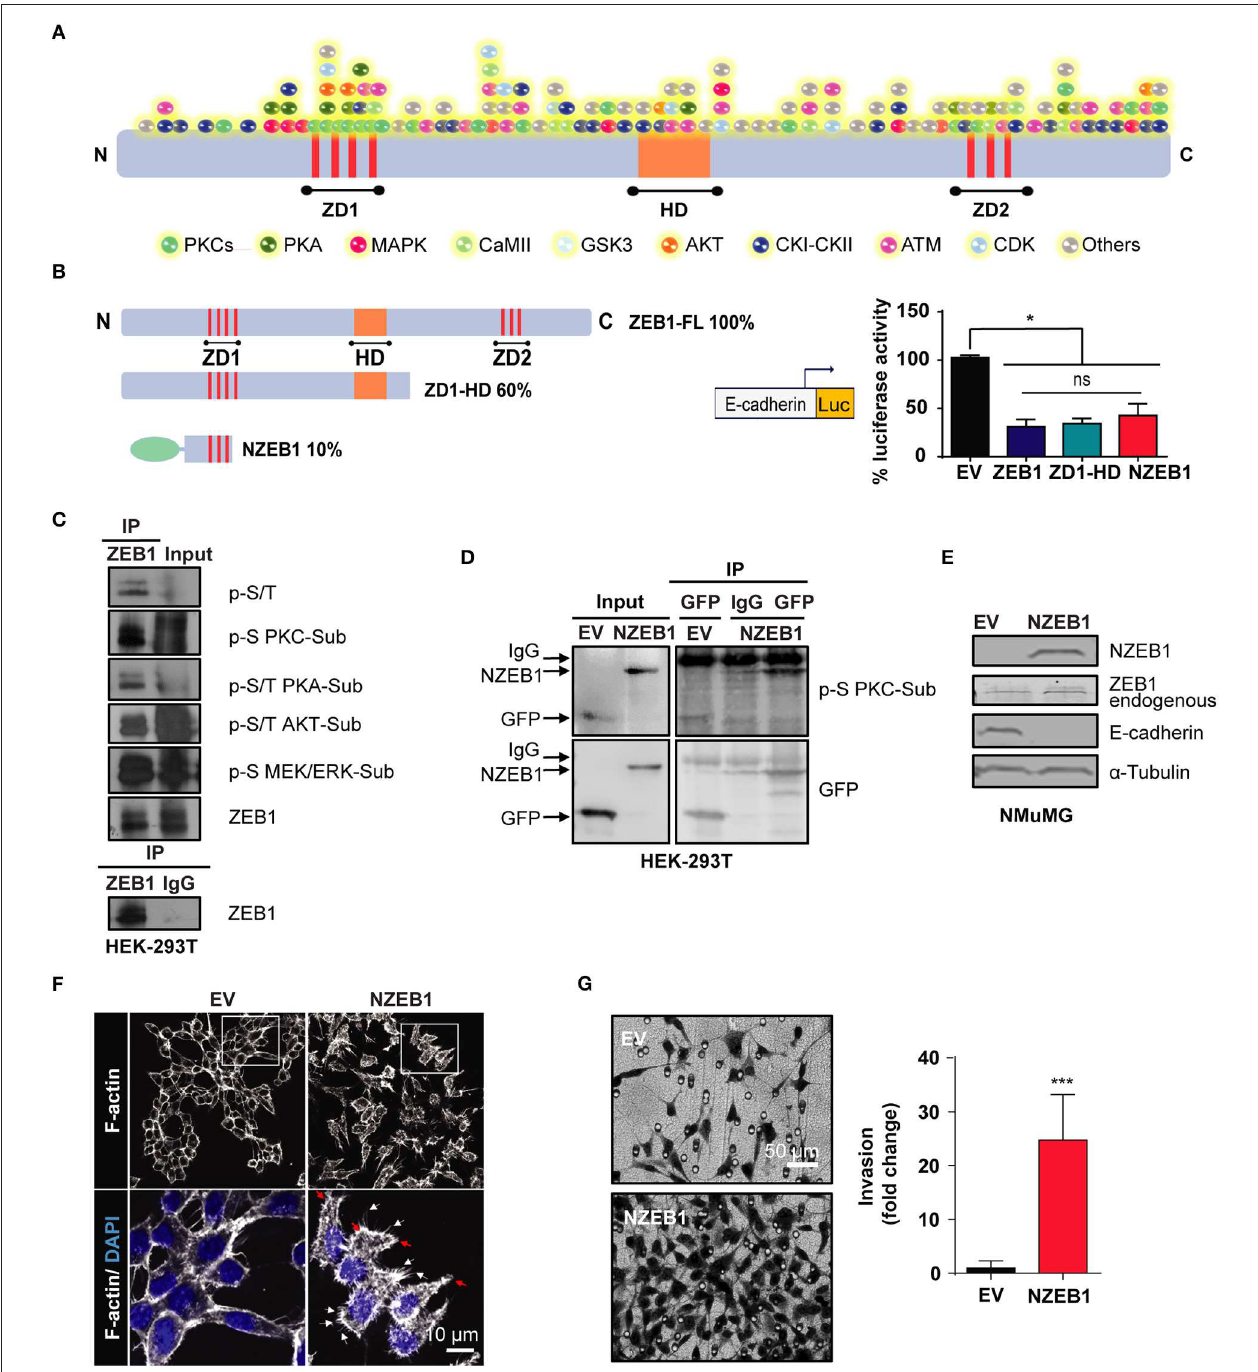
FIGURE 1 | An N-terminal fragment of ZEB1 which retains its EMT-inducing capacity is a phospho-substrate of PKCs. (A) Scheme of the in-silico analysis of ZEB1 potential phosphorylation sites. (B) Left: schematic representation of ZEB1 full-length ( ZEB1-FL ) and the deletion mutants used: ZD1-HD and NZEB1 ( ZD1 : N-terminal zinc finger cluster, HD : Homeodomain, and ZD2 : C-terminal zinc finger cluster). Right: Luciferase reporter assay of the E-cadherin promoter activity in HEK-293T cells co-transfected with either ZEB1-FL or ZEB1 deletion mutants. (C,D) Immunoprecipitation of ZD1-HD or NZEB1. Western blots were performed using a specific set of anti-phospho substrates antibodies for MEK/ERK (p-S MEK/ERK-Sub), PKCs (p-S PKC-Sub), PKA (p-S/T PKA-Sub) and AKT (p-S/T AKT-Sub) kinases; anti-phospho serine/threonine (p-S/T), anti-ZEB1 or anti-GFP. (E) Western blots for endogenous ZEB1, NZEB1 and E-cadherin in NMuMG epithelial cells stably expressing NZEB1 or GFP-Empty Vector (EV). (F) Confocal microscopy analysis of F-actin cytoskeleton distribution determined by rodamine-phalloidin staining ( white ) in stable NZEB1 or EV NMuMG cell lines. Nuclei were stained with DAPI ( blue ). Magnification: 60X; Bar: 10 µ m. Red and white arrows indicate lamellipodia and filopodia, respectively. (G) Matrigel invasion assay in NZEB1 or EV NMuMG cells. Magnification: 10X. Bar: 50 µ m. Results are expressed as mean ± S.D > . ns , not significant, * p ≤ 0.05, *** p ≤ 0.001).